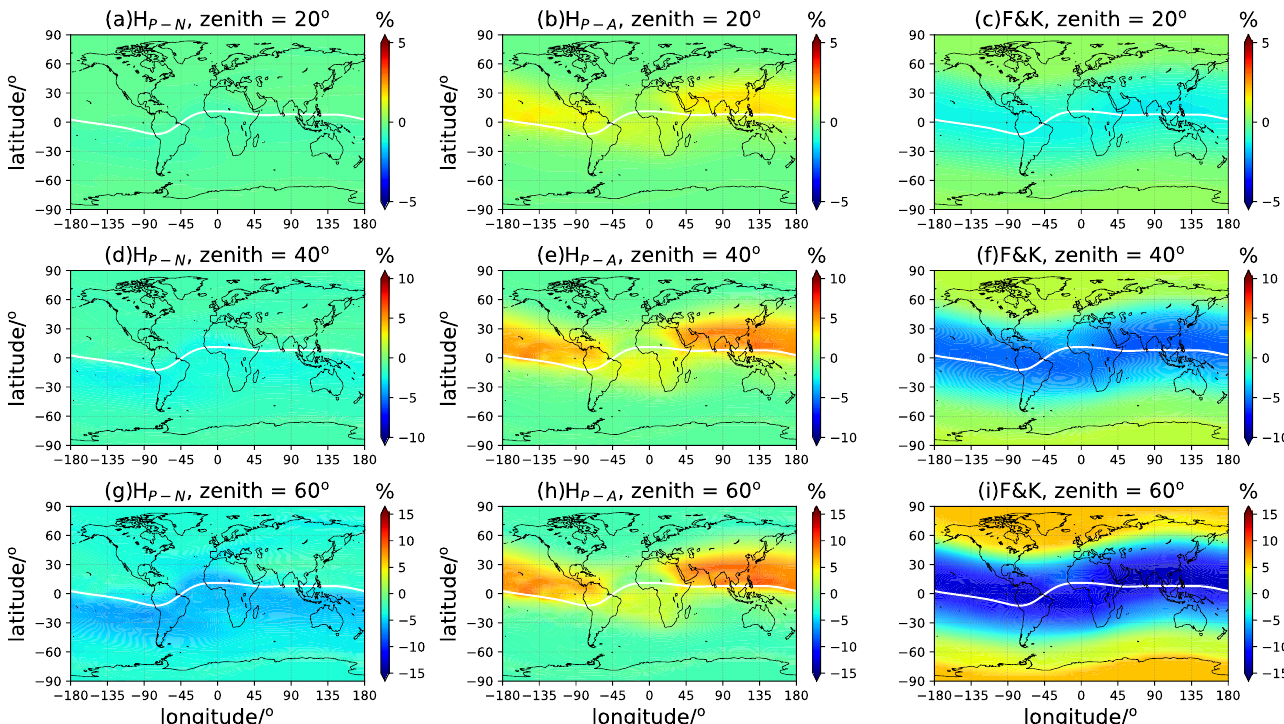
Figure 8. The longitude- and latitude-dependent variations of the retrieved VTEC mean deviation in the December solstice in LSA years. The zenith angle is chosen at 20° (panels ( a ), ( b ), and ( c )), 40° (panels ( d ), ( e ), and ( f )), and 60° (panels ( g ), ( h ), and ( i )), respectively. The ‘ 𝐻 𝑃_𝑁 ’, ‘ 𝐻 𝑃_𝐴 ’ , and ‘F&K’ represent the numerical and analytical mapping functions and the F&K model, respectively.